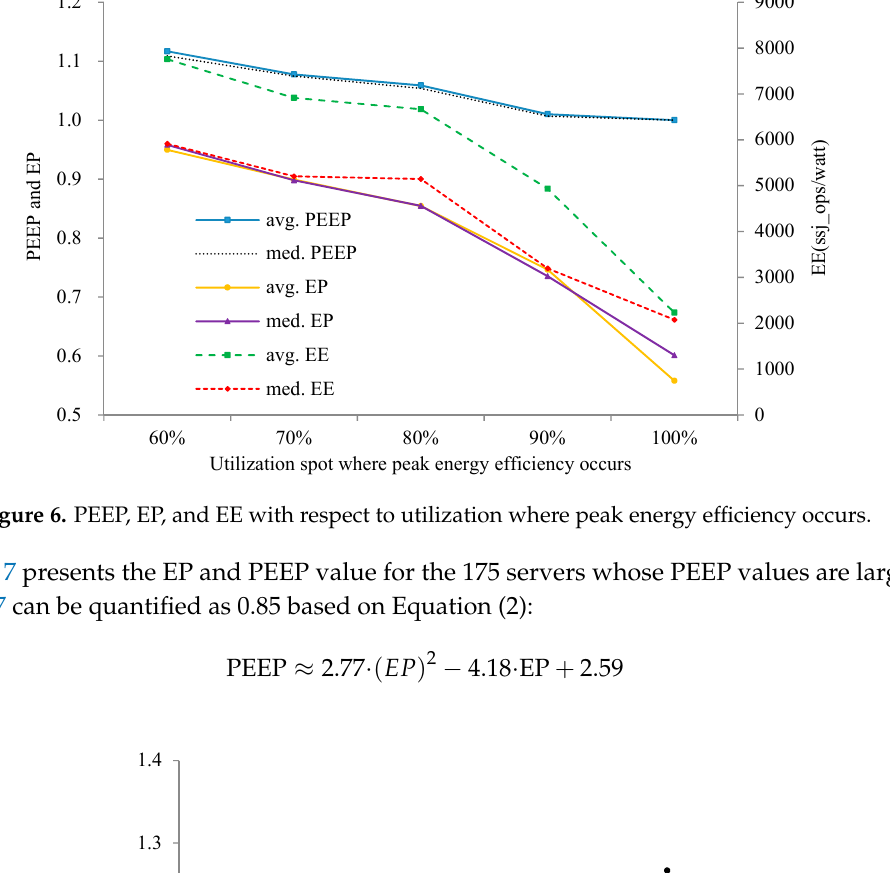
Figure 6. PEEP, EP, and EE with respect to utilization where peak energy efficiency occurs.